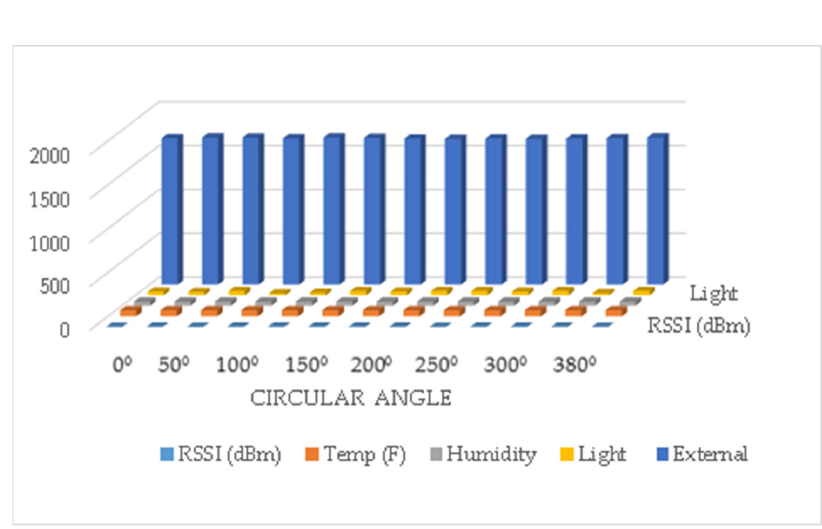
Figure 8. 100° Sense Data from Patch Antenna.